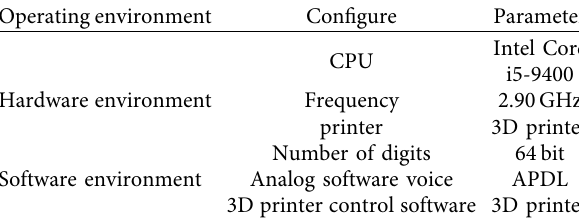
Table 1: Simulation software operating